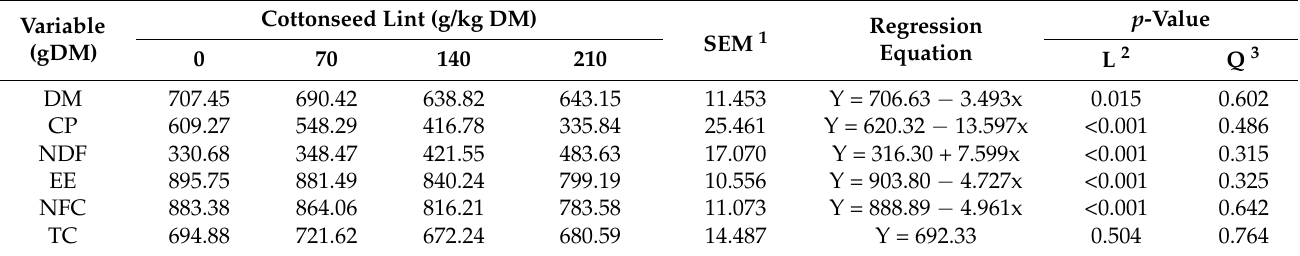
Table 5. Apparent digestibility of dry matter (DM), crude protein (CP), ether extract (EE),